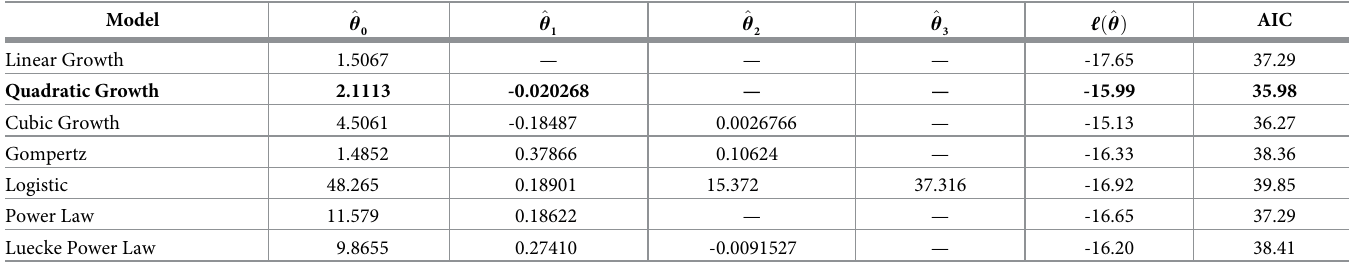
Table 30. Fetal hematocrit models (percentage vs. gestational age in